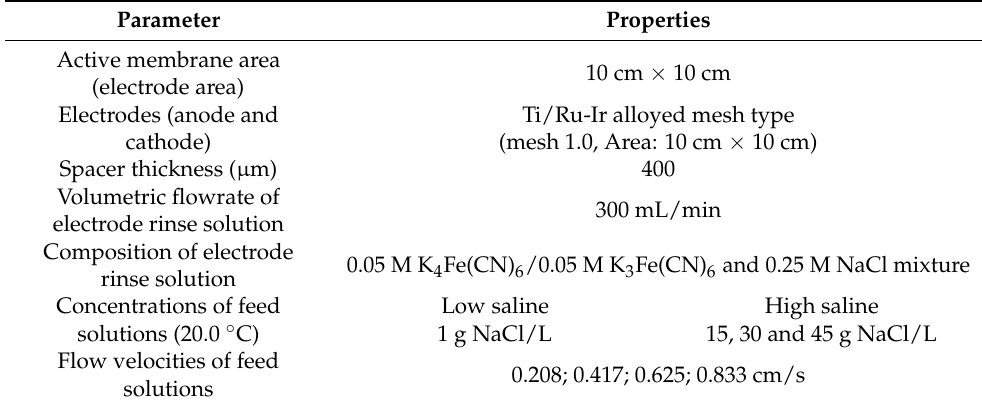
Table 2. Technical information of the RED system.